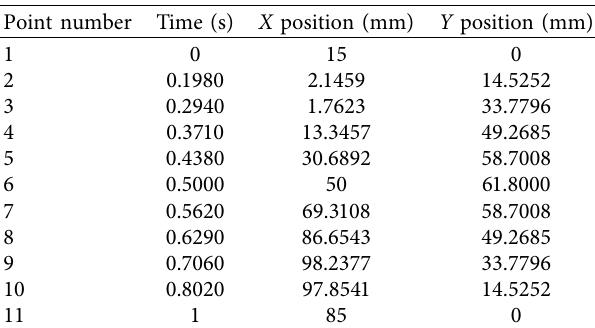
Table 4: Corresponding trajectory points of uniform